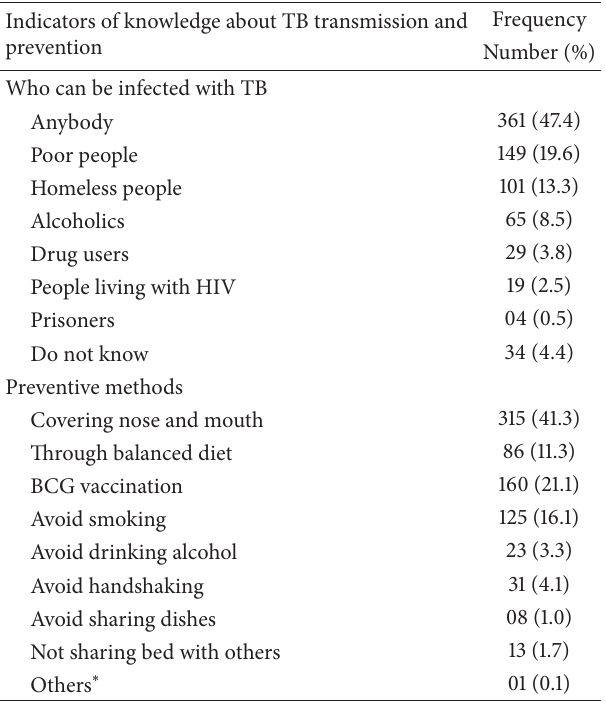
Table 5: Respondents’ knowledge on transmission and prevention of TB.